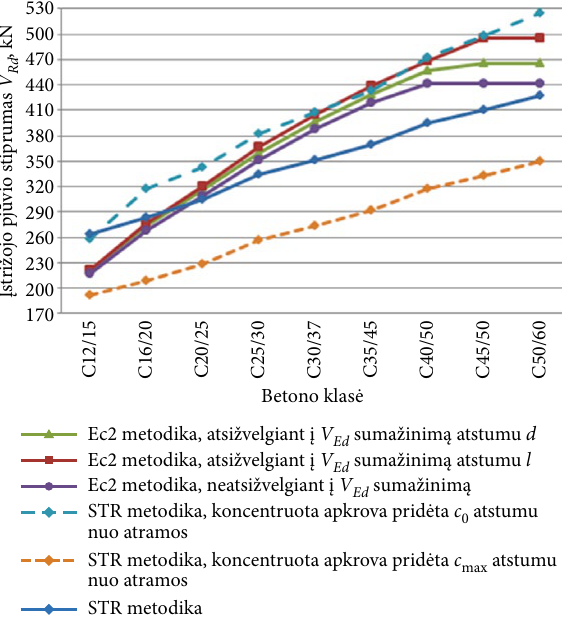
7 pav. Armuotų skersine armatūra lenkiamųjų elementų įstrižojo pjūvio stiprumo priklausomybė nuo betono klasės Fig. 7. The relationship between shear strength of bending elements with shear reinforcement and the class of